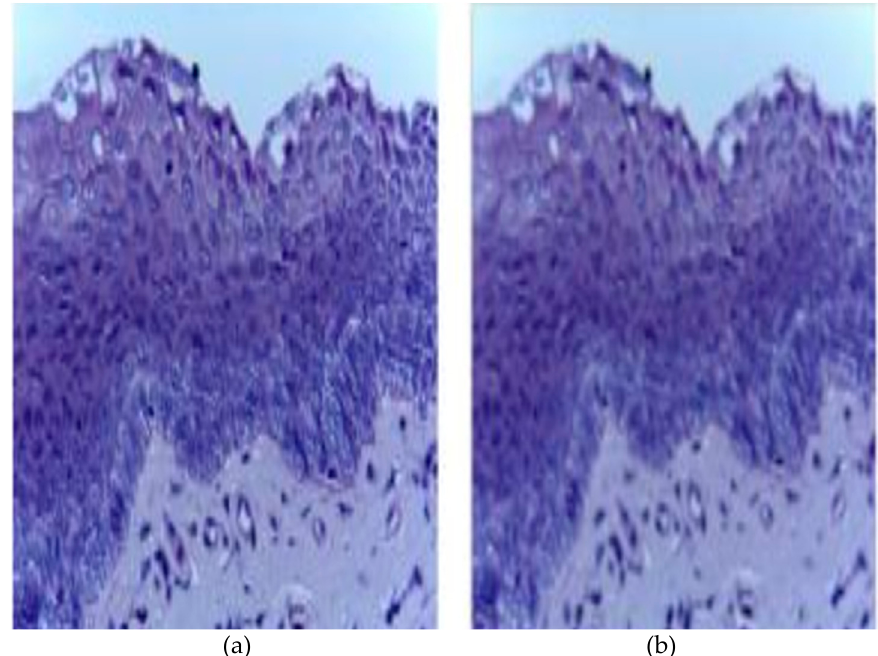
Figure 2. ( a ) Original histopathological oral image; ( b ) resultant image after Gaussian filter is ap- plied.